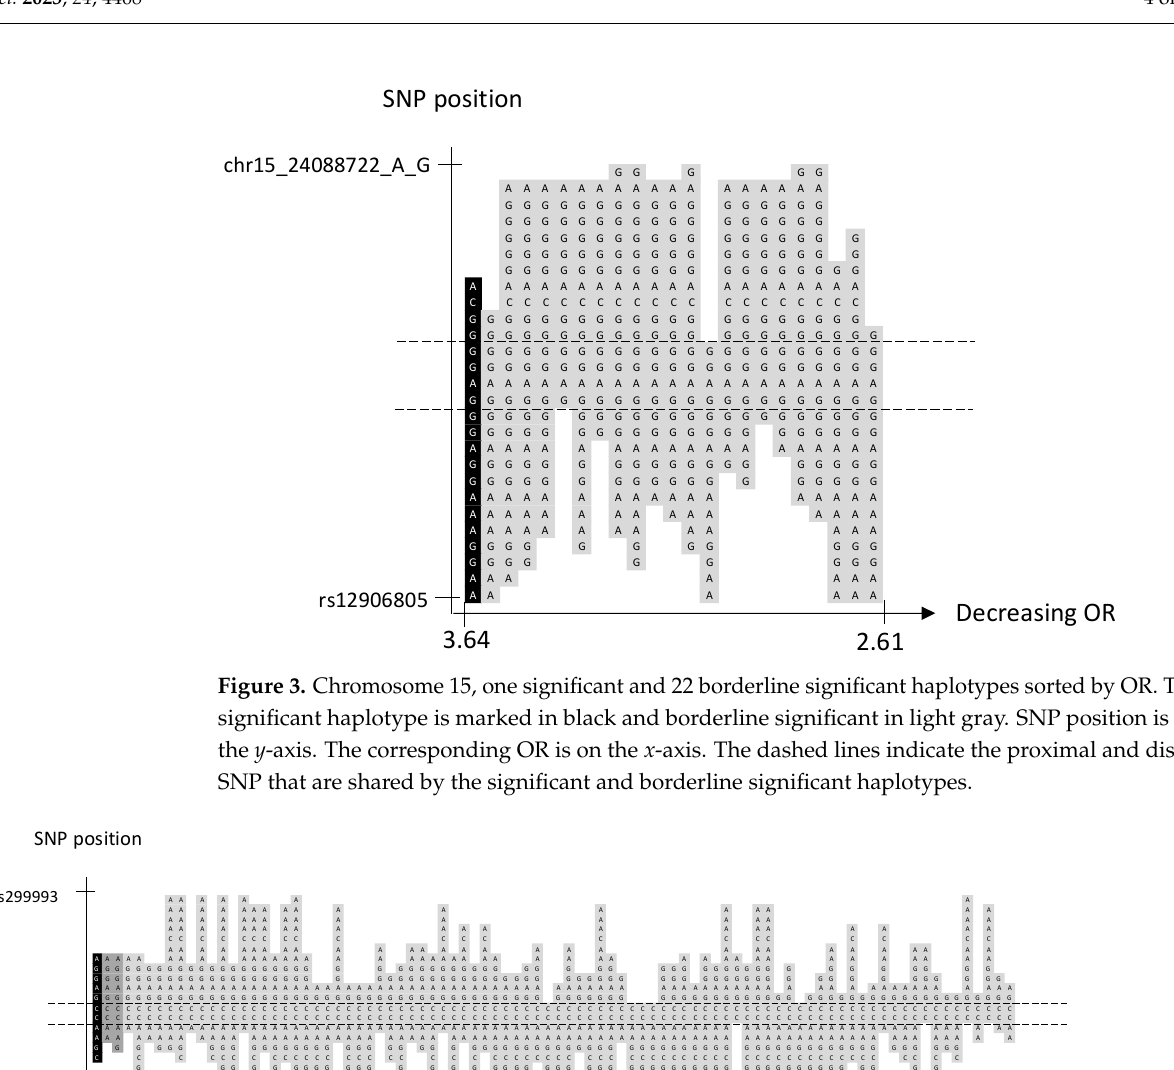
Figure 2. Chromosome 11, one significant haplotype and three borderline significant haplotypes sorted by OR. The significant haplotype is marked in black and borderline significant in light gray. SNP position is on the y -axis. Gene position for GRIA4 is indicated along the y -axis. The correspond- ing OR is on the x -axis. The dashed lines indicate the proximal and distal SNP that are shared by the significant and borderline significant haplotypes.